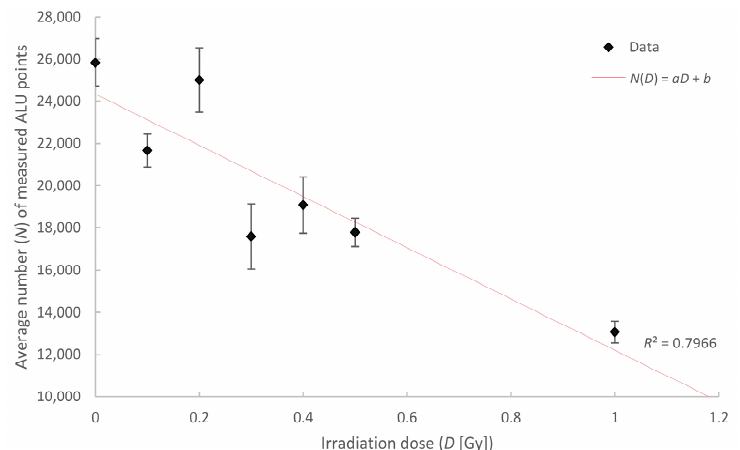
Figure 7. Average number of measured ALU elements relative to the radiation exposure dose. The data were detected after specimen fixation 30 min after irradiation with 6 MeV photons. The measurement data is fitted by a linear curve ( N ( D ) = aD + b ) with the parameters: a = − 12,143, and b = 24,345. The error bars reflect the variations between the individual cells.